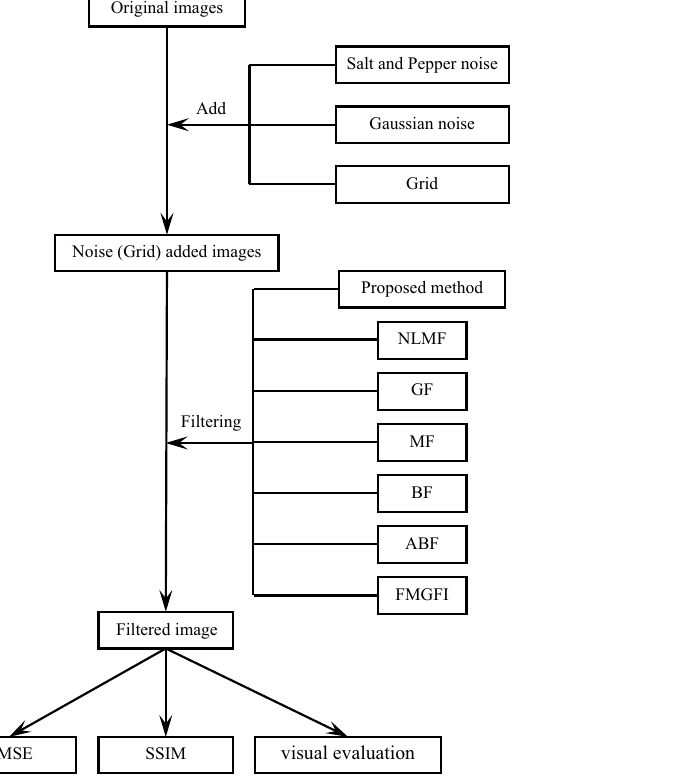
Figure 6. Experimental procedure.